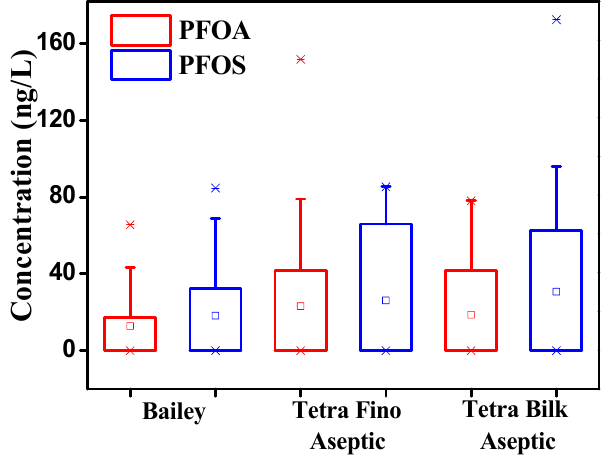
Figure 3. Concentrations (ng/L) of PFOA and PFOS in milk for different packaging materials (Bailey: polyethylene, n = 20 ; Tetra Fino Aseptic: a laminate of paper, polyethylene and aluminum foil, n = 20 ; Tetra Bilk Aseptic: a laminate of paper, polyethylene and aluminum foil, n = 20 ). Note: □ , mean; *, maximum and minimum.